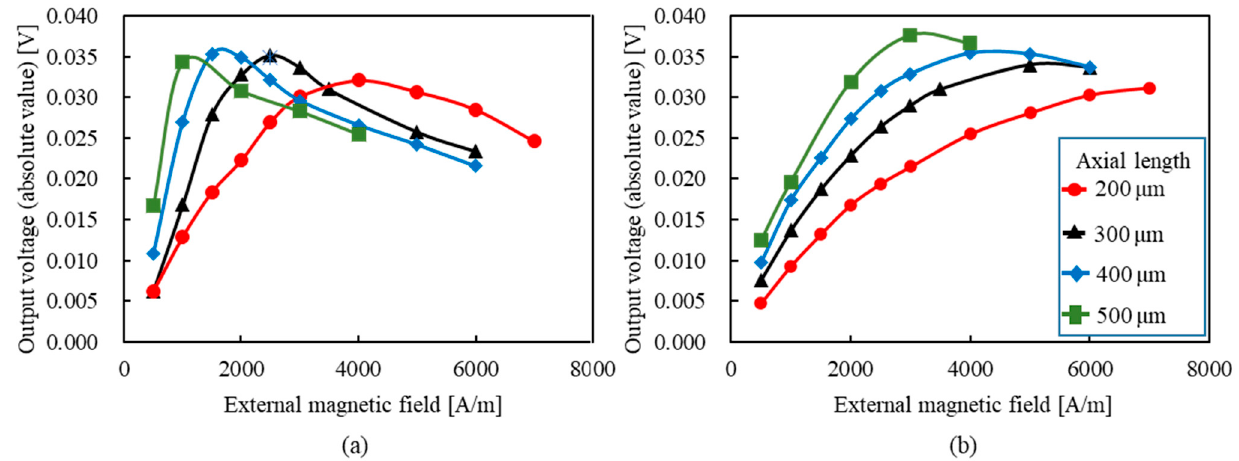
Figure 10. Relationship between the external magnetic field and the output voltage: ( a ) rise-time output voltage; ( b ) fall-time output voltage.